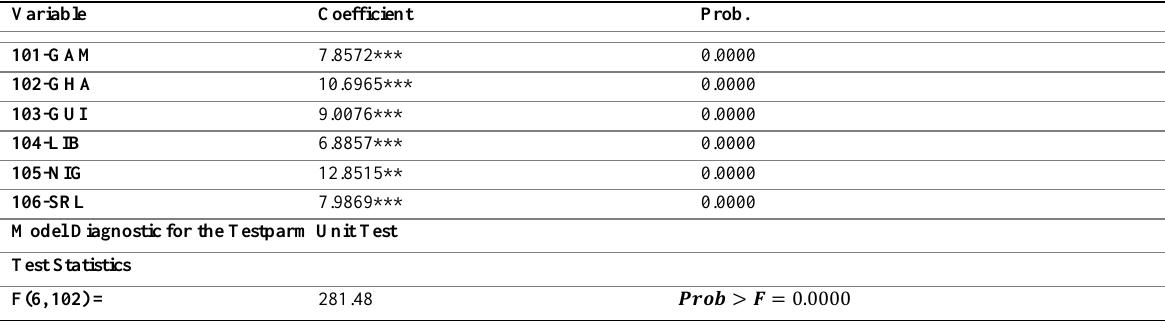
Table 3: Test Random Effects and Fixed Effects Estimators